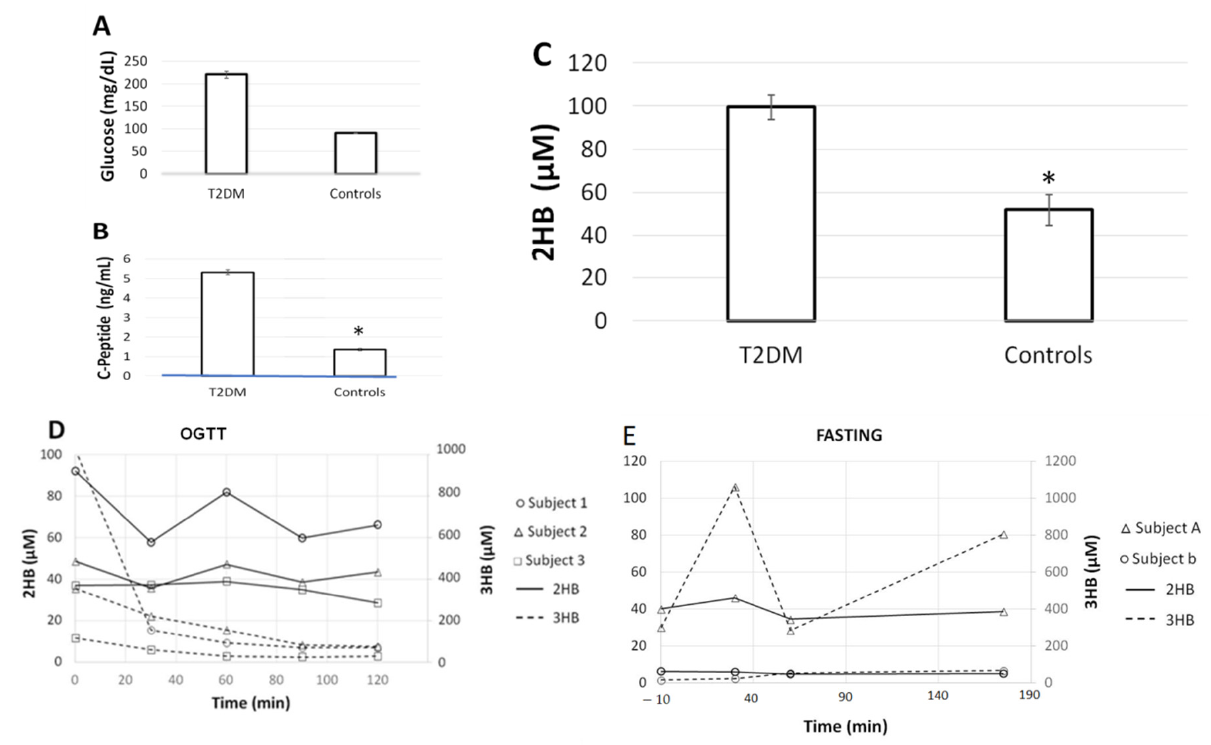
Figure 3. Basal serum levels (mean ± SEM) of ( A ) glucose, ( B ) C-Peptide and ( C ) 2-hydroxybutyrate (2HB). Serum levels of 2-hydroxybutyrate (2HB) and β -hydroxybutyrate (3HB) after ( D ) oral glu- cose tolerance test (OGTT) and ( E ) fasting up to 180 min. * p < 0.05, Student’s t